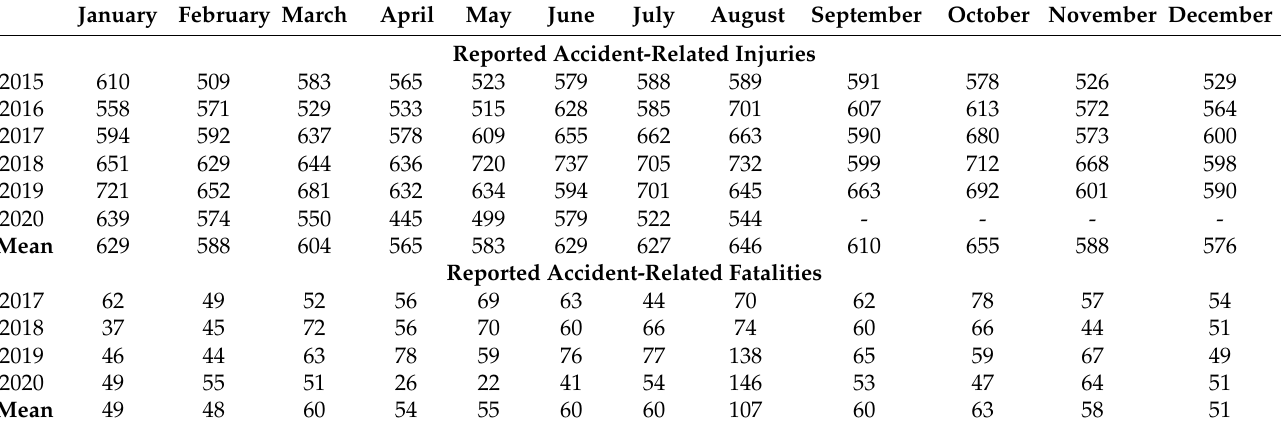
Table 5. Number of accident-related injuries and fatalities reported per month per year.